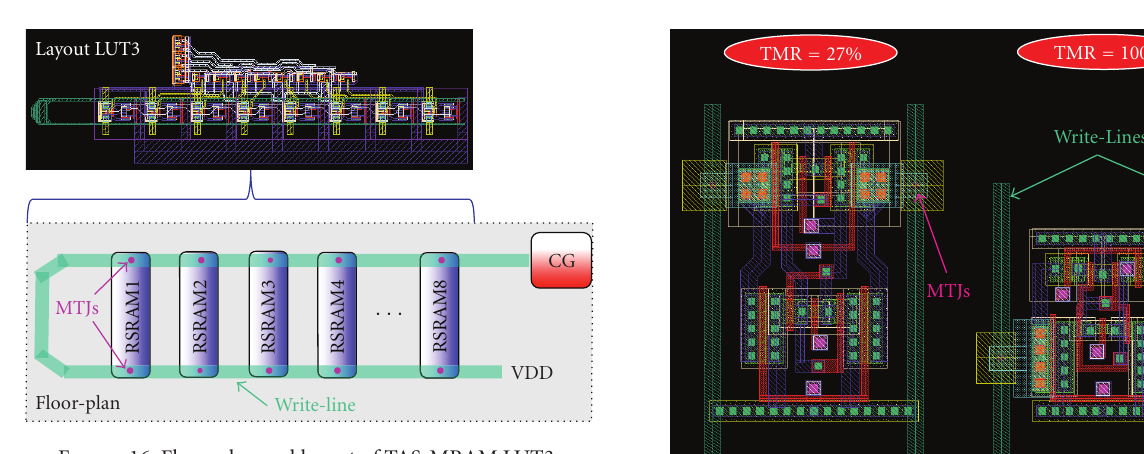
Figure 16: Floor-plan and layout of TAS-MRAM LUT3.